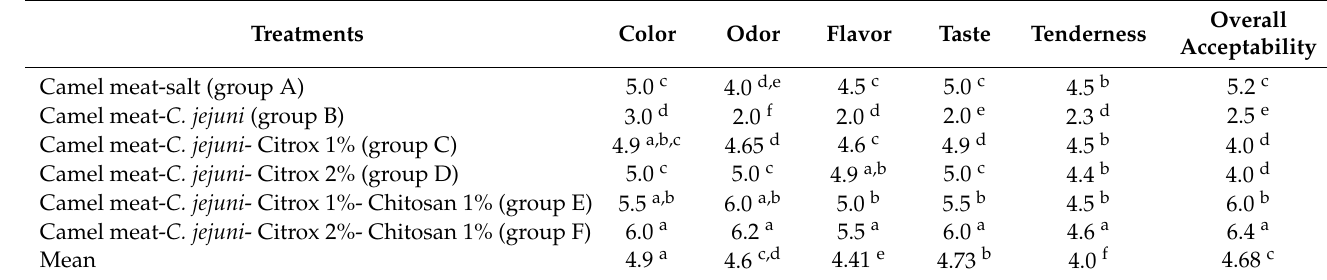
Table 2. Sensory evaluation of camel meat samples treated with 1% or 2% Citrox. Treatments Color Odor Flavor Taste Tenderness